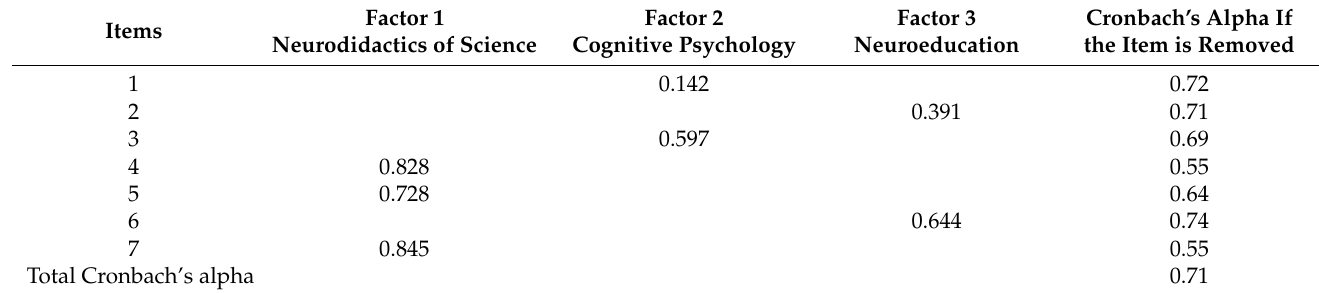
Table 3. Matrix-rotated component and Cronbach’s Alpha